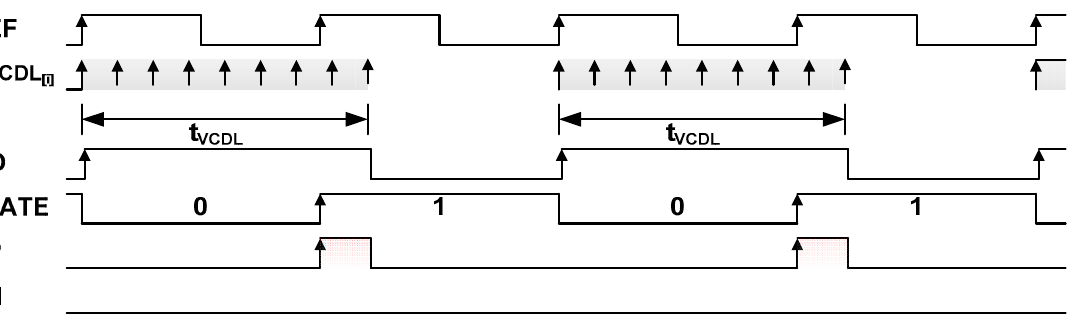
Figure 6. Timing diagram for the PD-MDV operation under the condition t REF < t VCDL ≤ 2· t REF .